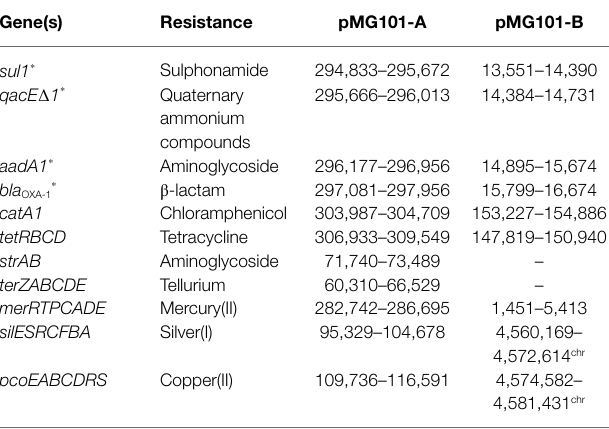
TABLE 3 | Locations of ARGs and metal resistance genes (MRGs) within pMG101-A and pMG101-B.